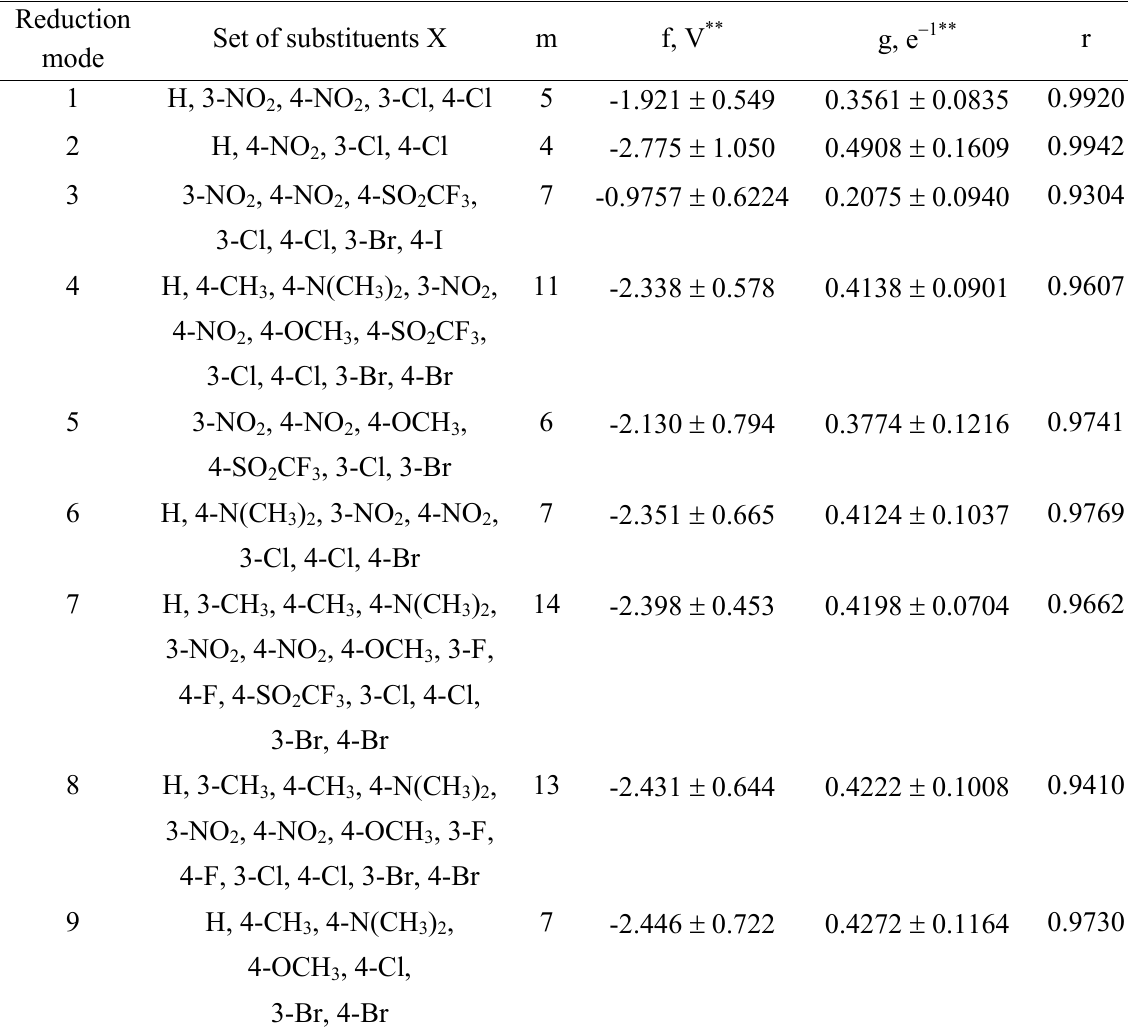
H N + ≡ N cations titration, potentials 6 4